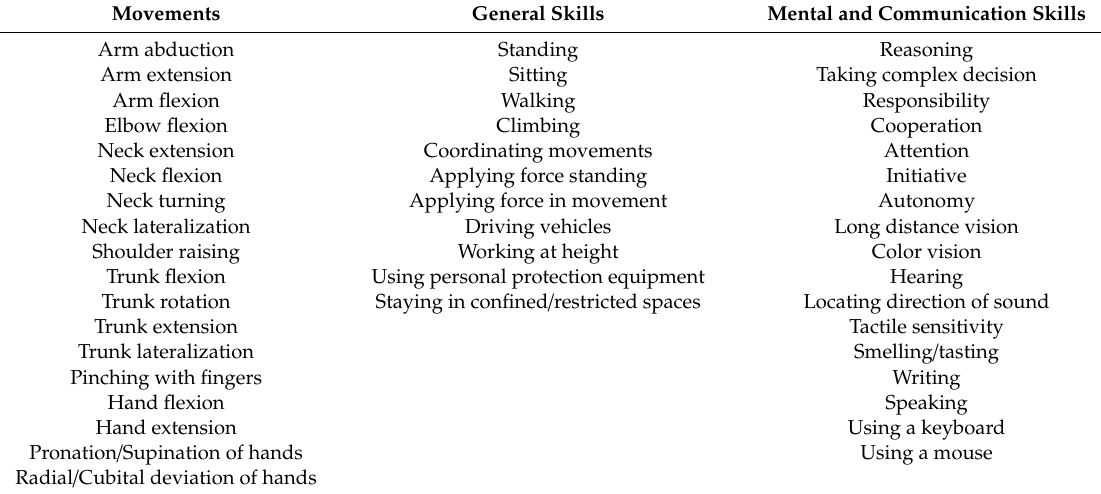
Table 1. Criteria employed to characterize workers and workstations. The skills and capacity to perform the movements of the workers are matched with those required by the jobs.